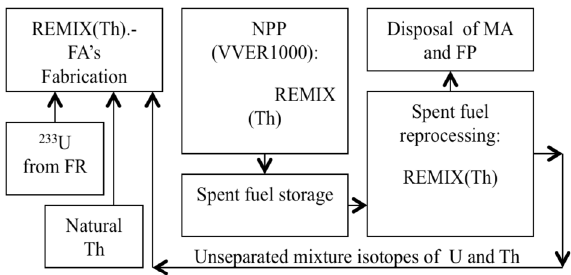
Fig. 9. The fl owchart with REMIX(MOX)-fuel.